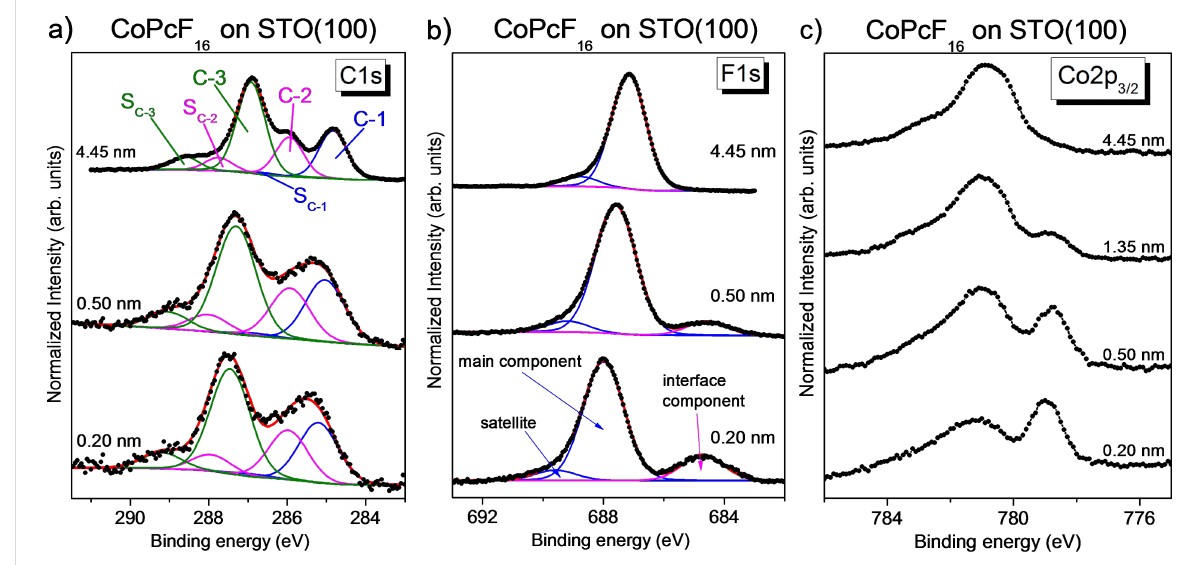
Figure 4: CoPcF 16 on STO(100). Thickness-dependent core level spectra: (a) C 1s, (b) F 1s, and (c) Co 2p 3/2 . Distinct interface components are visible in the F 1s and Co 2p 3/2 spectra.